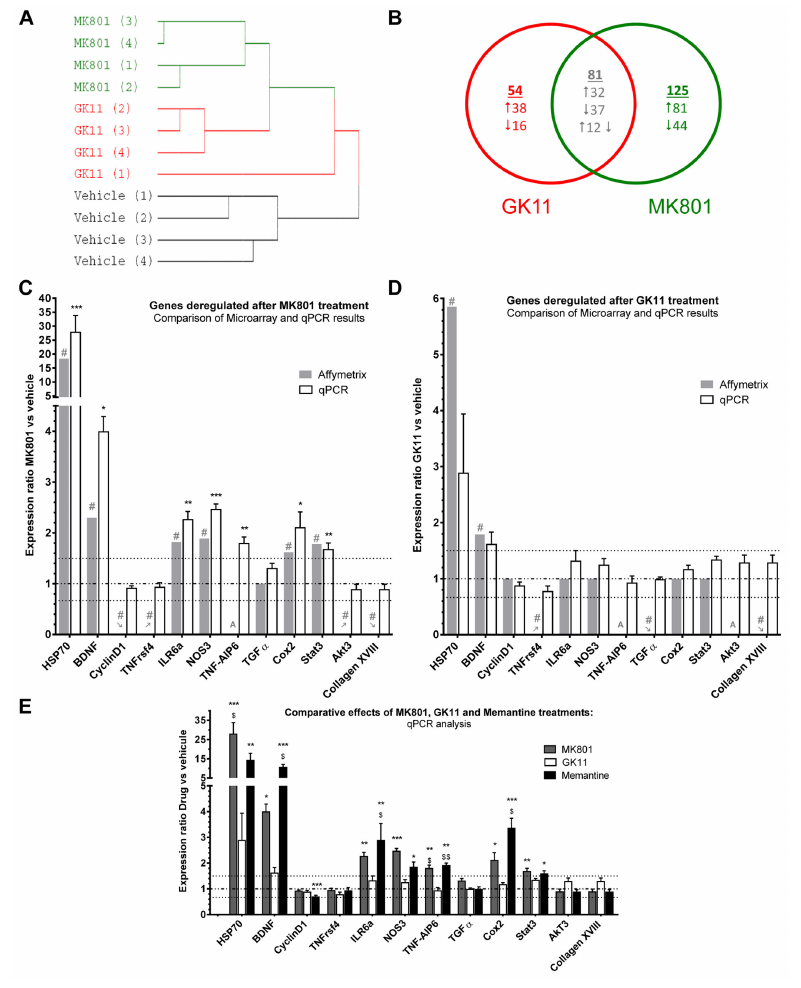
Figure 2. Microarray results and validation by qPCR. Comparison of the effects of MK801 and GK11 on gene expression in the cingulate cortex using microarray and qPCR